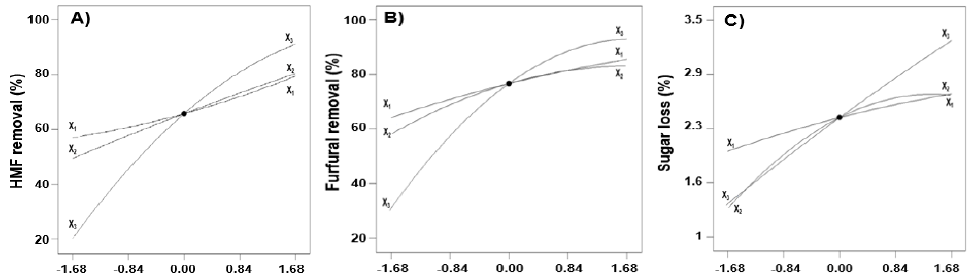
Figure 1. Effect of independent variables on 5-HMF removal ( A ), furfural removal ( B ), and sugar loss ( C ). Each level of variable was expressed as code values. Extraction temperature (X 1 ); extraction time (X 2 ); S-L ratio (X 3